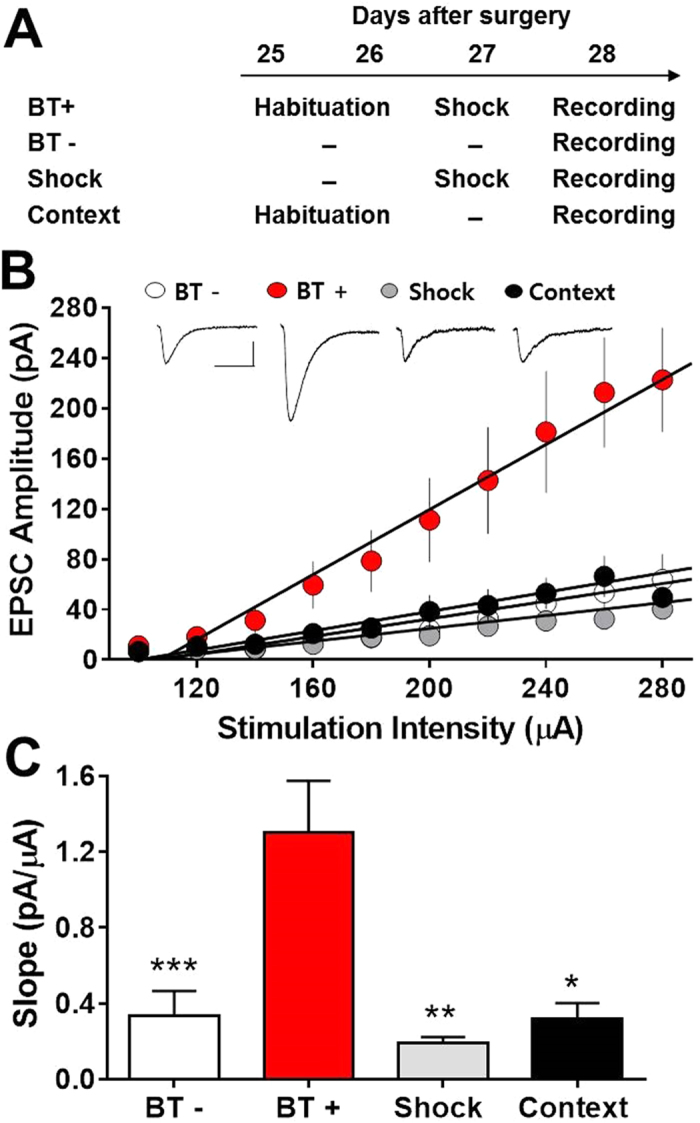
IA learning produces LTP at synapses onto the implanted HiB5 cell-derived neurons.(A) Schematics for behavioral treatments: IA learning (BT+), homecage control (BT−), shock control (Shock) and context control (Context). Numerals indicate days after surgery. (B) Input-output relationships of EPSCs for implanted HiB5 cell-derived neurons in slices from rats with different behavioral treatments as shown in A. Insets demonstrate averaged current traces of five consecutive EPSC responses with input stimulations of 280 μA. Scale bars, 40 ms and 40 pA. (C) Comparison of the slopes calculated from the input-output curves shown in B. The slope from BT+ rats was significantly greater than that from BT−, shock or context control rats. *P < 0.05, **P < 0.01, ***P < 0.001, one-way ANOVA with Newman-Keuls posttest (compared with BT+). Values are mean ± SEM.